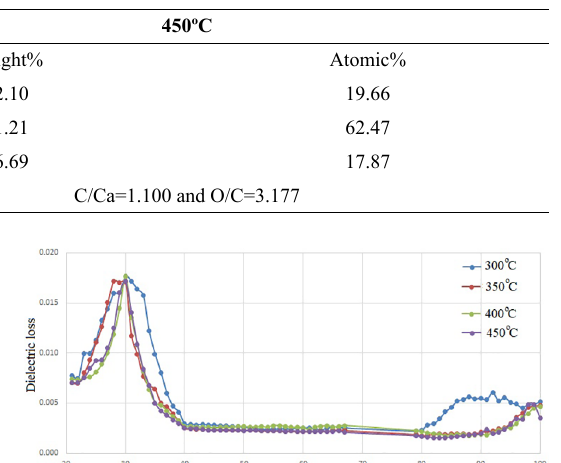
Figure 9. The dielectric loss of CaCO temperature as a function of driven